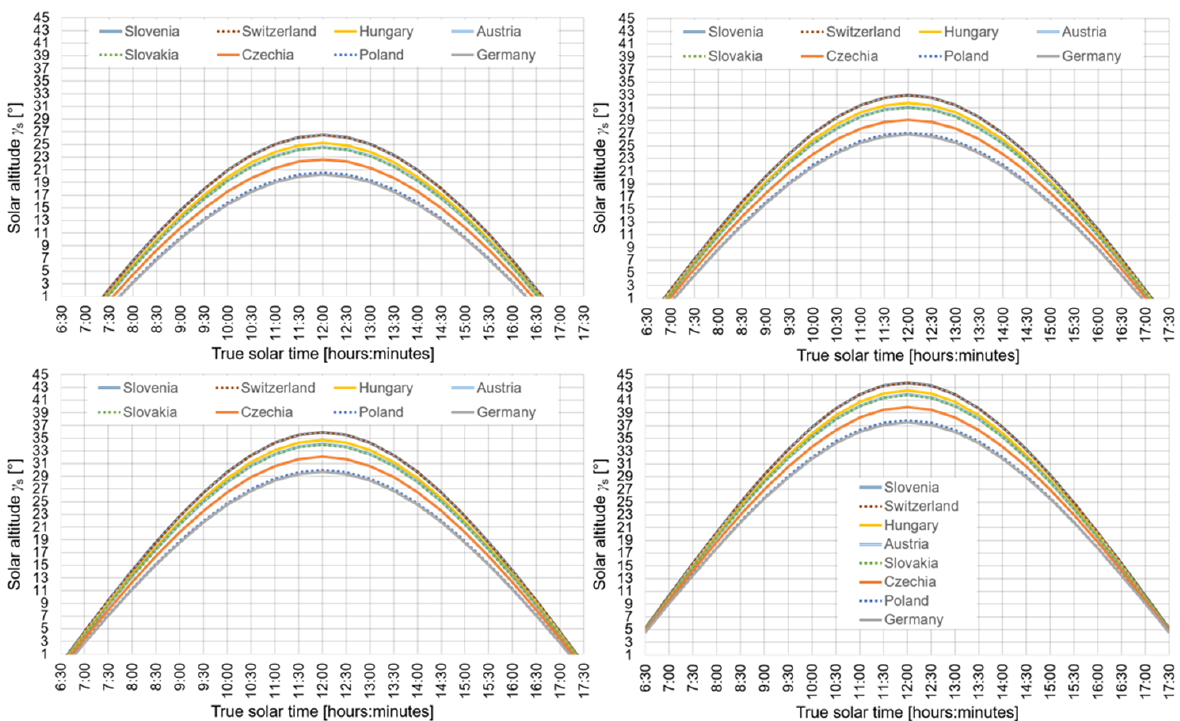
Figure 2. Dependence of the sun altitude on the time (top left for 1 st February, top right for 21 st February, bottom left for 1 st March, bottom right for 21 st March).